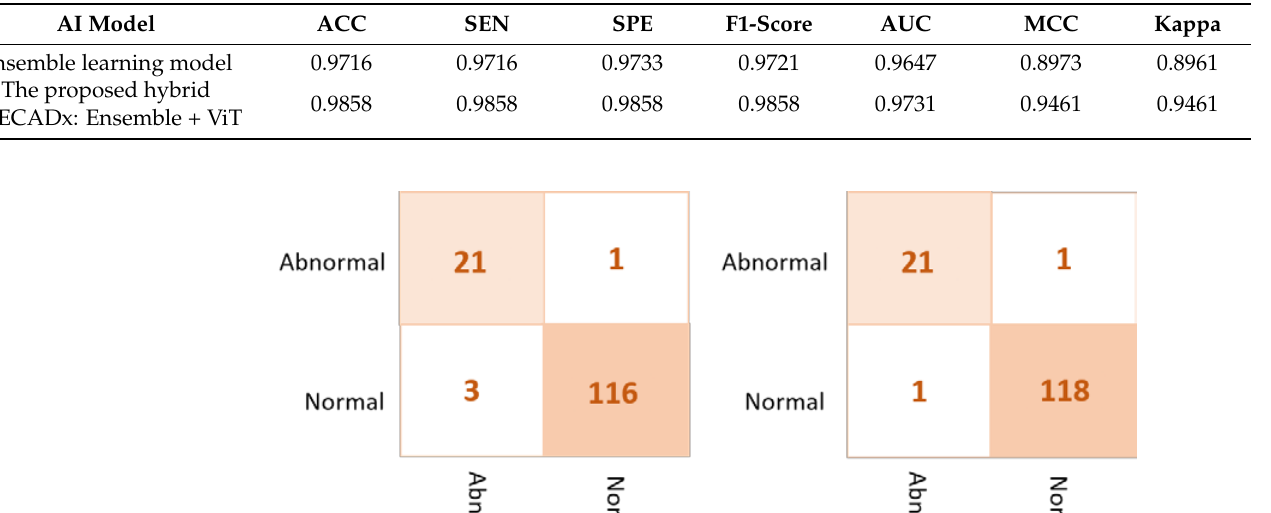
Figure 7. Example of the confusion matrices in the binary approach for individual pre-trained models using INbreast testing set : ( a ) DenseNet201, ( b ) InceptionResNetV2, and ( c ) Xception.